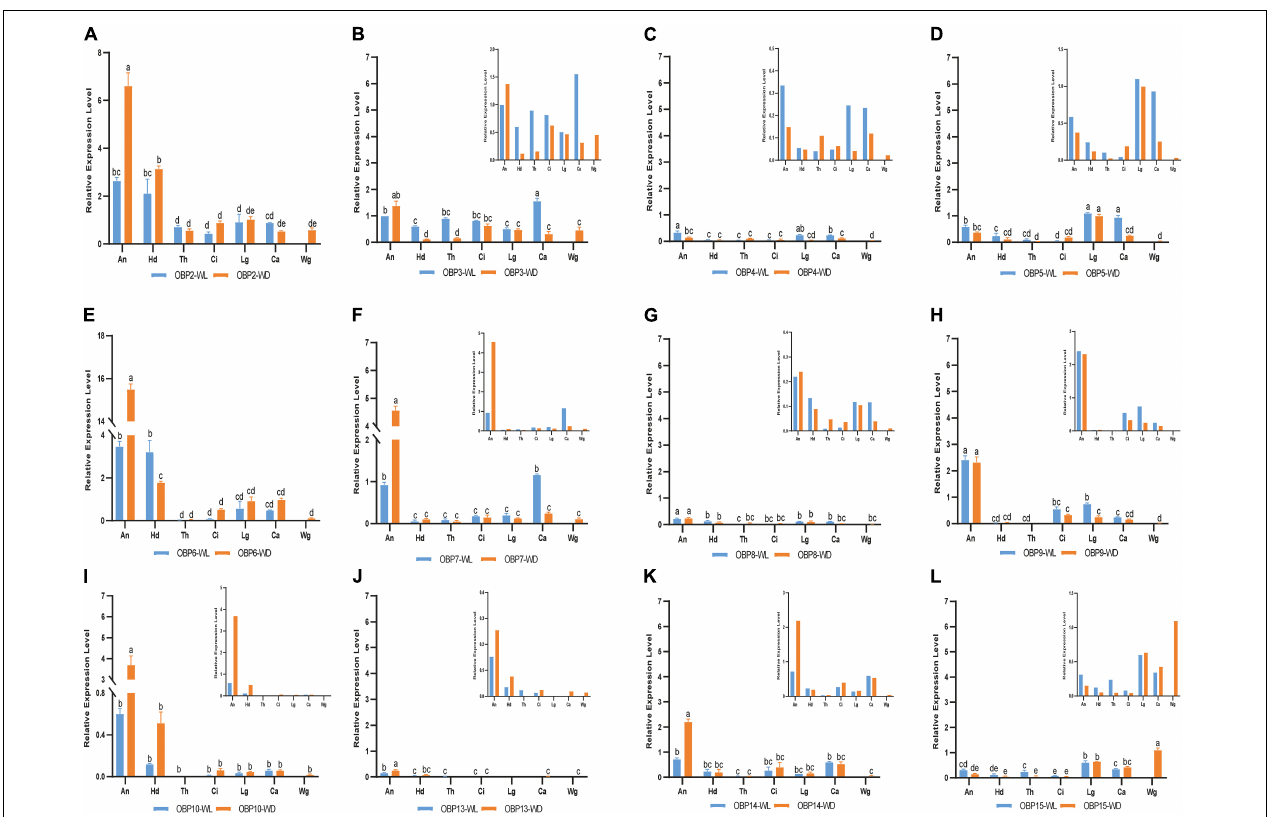
FIGURE 5 | RT-qPCR detection of each OBP expression pattern in seven tissues; WL, wingless; WD, winged; An, antennae; Hd, head; Th, thorax; Ci, cornicle; Lg, leg; Ca, cauda; Wg, wing. Bars represent the standard deviation of the mean for three independent experiments. (A–L) are the detection results of each OBP expression pattern in seven tissues and the sequence is from OBP2 to OBP10 and OBP13 to OBP15, respectively. The letters above bars (a–e) are the result of a multicomparison, which indicated significant differences from other samples with different letters ( p <